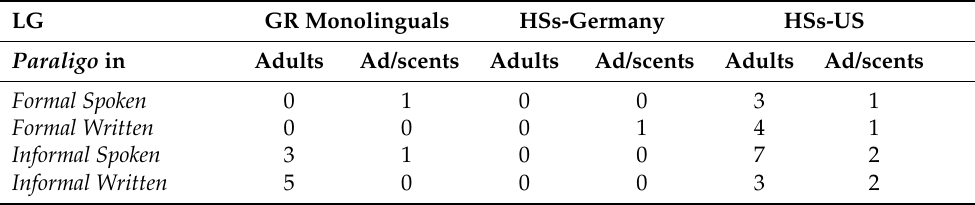
Table 3. Distribution of paraligo per settings and modalities across language and age groups. LG GR Monolinguals HSs-Germany HSs-US Paraligo in Adults Ad/scents Adults Ad/scents Adults Ad/scents Formal Spoken 0 1 0 0 3 1 Formal Written 0 0 0 1 4 1 Informal Spoken 3 1 0 0 Informal Written 5 0 0